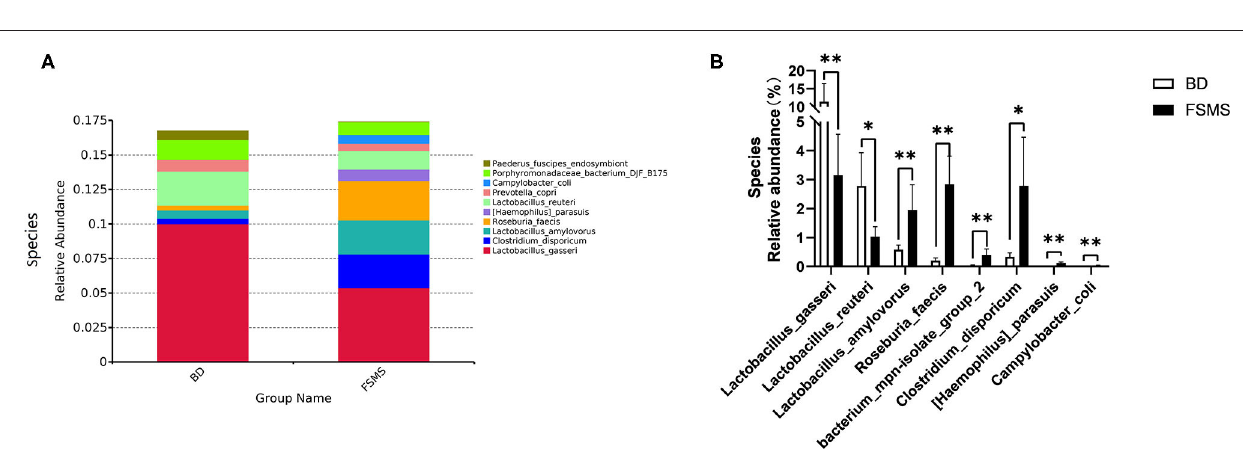
concentrations of T3 increased by 27.86% and serum